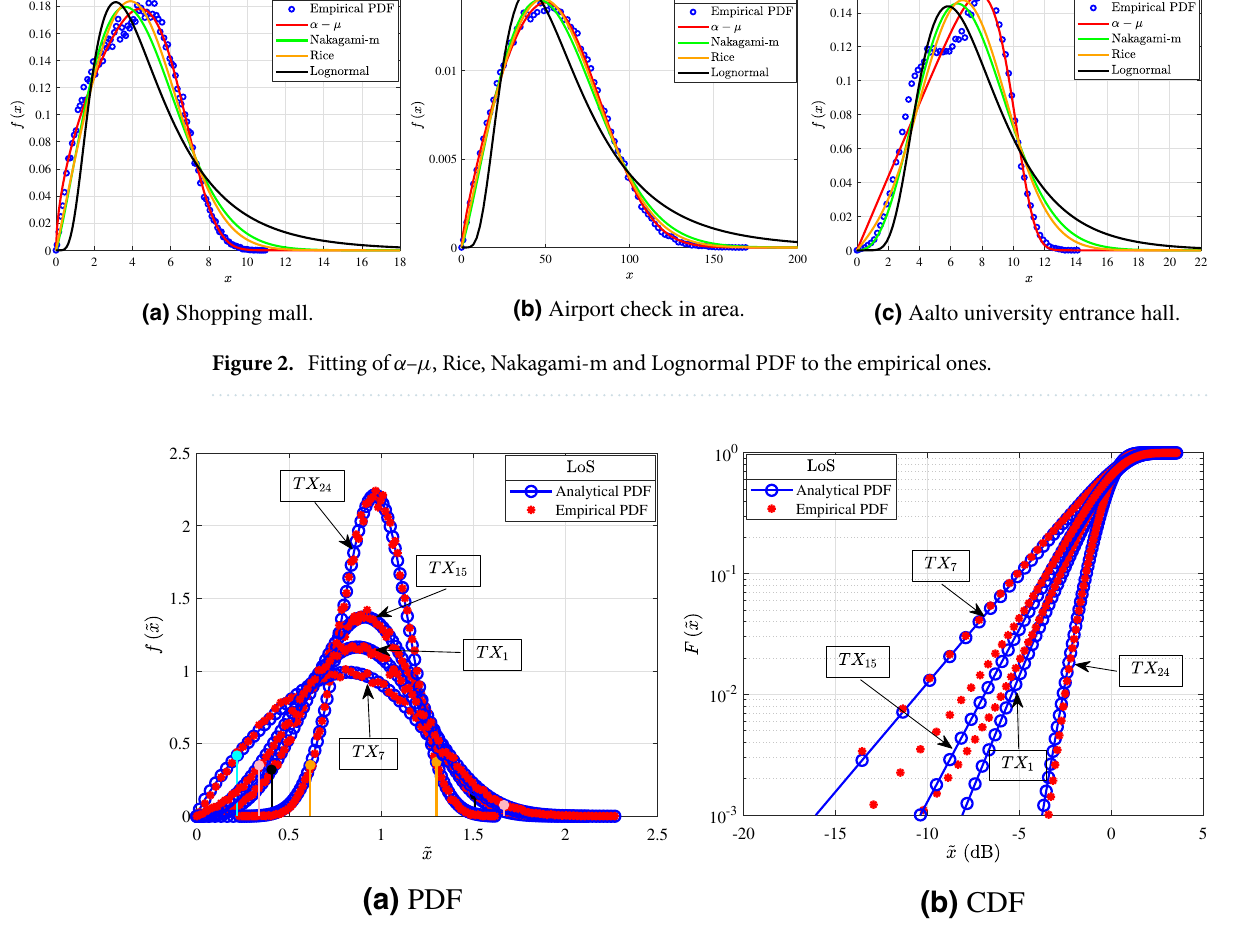
Figure 3. Fitting of PDF and CDF analytical expressions to the empirical channel gain data of some indicative LoS links (1, 7, 15, and 24) for the shopping mall measurements.